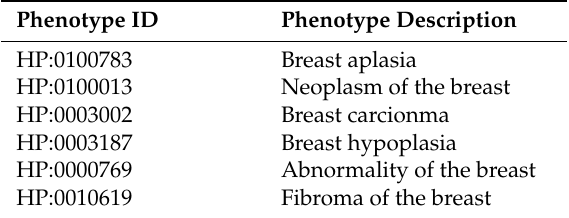
Table 5. UberPheno phenotype terms selected for identification of the differentially regulated sub-network with the potential anticancer mechanism of bufadienolide-like